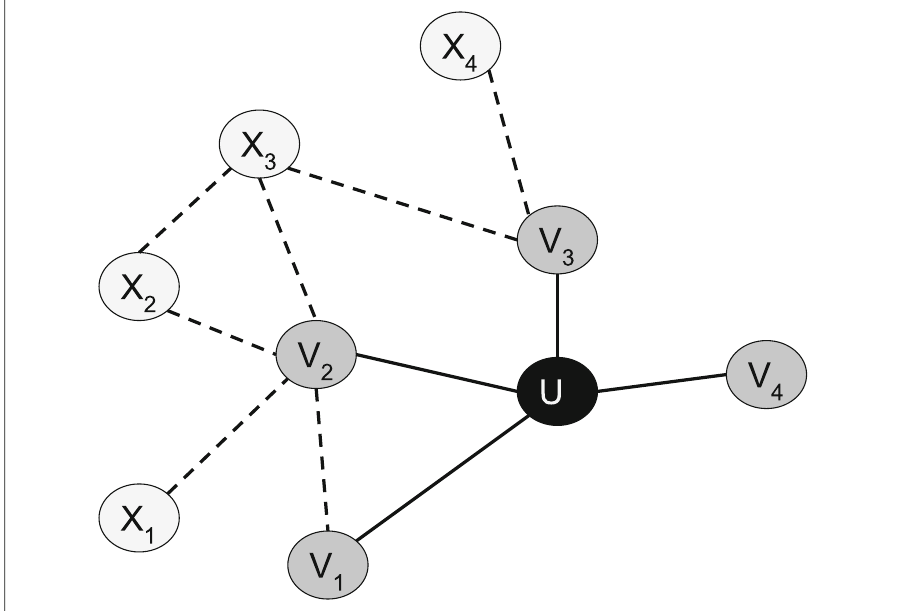
Fig. 2 Example of an incomplete network. The black node U is probed and gray nodes V 1 , ··· , V 4 are observed. The white nodes X 1 , ··· , X 4 exist in the original network G , are yet to be